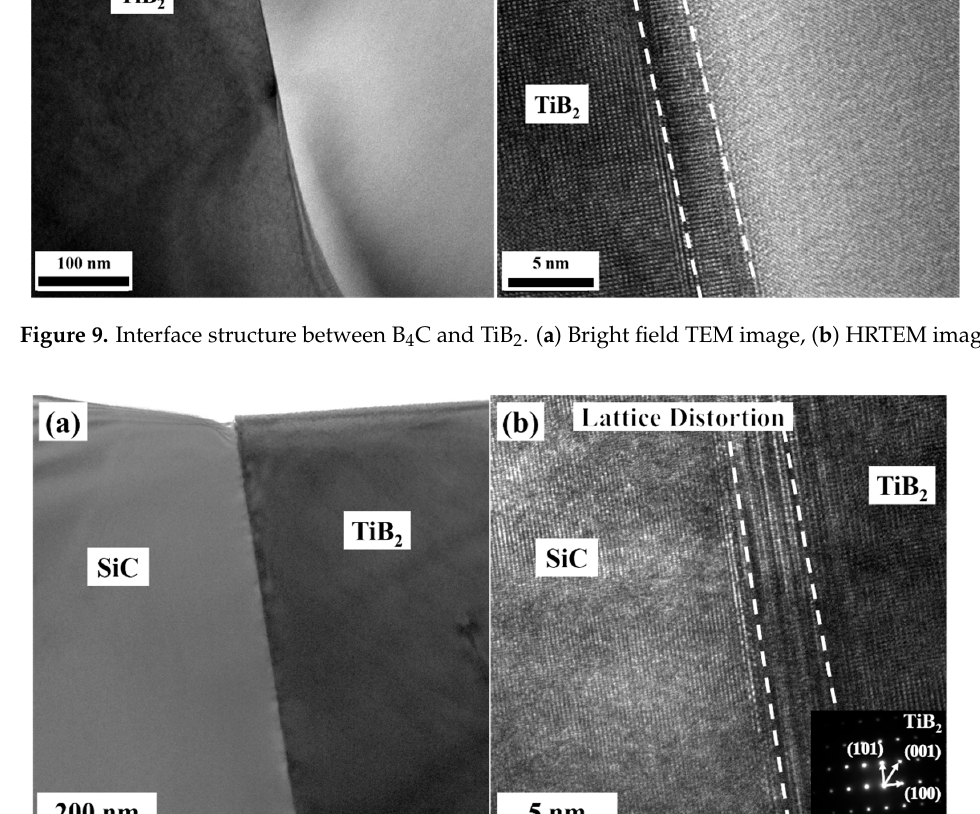
Figure 10. Interface structure between SiC and TiB 2 . ( a ) Bright field TEM image, ( b ) HRTEM image. Table 2. Mechanical properties of the B 4 C/TiB 2 ceramic composites.